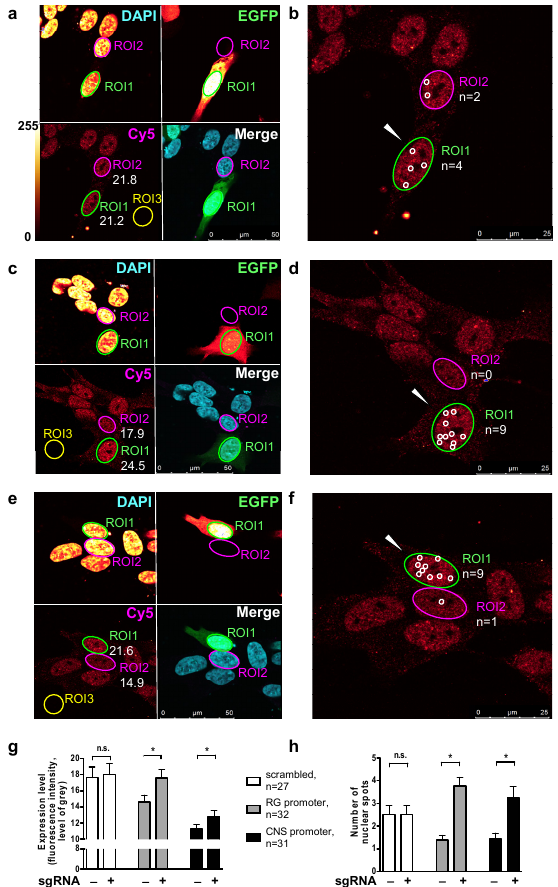
Figure 2. Targeted activation of the RG or CNS promoters increases the expression of PGC-1 α proteins in sgRNA transfected clonal SH-SY5Y cells expressing dCas9-VPR. ( a , c , e ) From top left to bottom right: fluorescent signal of cellular nuclei counterstained with 4 ′ ,6-diamidino-2-phenylindole (DAPI), EGFP, Cy5 (antibody directed against the N-terminal region of reference/CNS PGC-1 α ) and the corresponding merged image in cells transfected with scrambled sgRNA or sgRNAs targeting the RG and CNS PPARGC1A promoters, respectively. Numbers in the lower left section of panels refer to the fluorescence intensity of Cy5 (levels of gray) determined in regions of interest (ROIs) corresponding to the nucleus of adjacent transfected (EGFP-expressing, ROI1) and mock-transfected (not expressing EGFP, ROI2) cells. ROIs depicted outside the cells (ROI3) served to determine the background fluorescence. The fluorescence intensity scale shown in ( a ) also applies to ( c , e ). ( b , d , f ) Magnification of the lower left section of panels (a), (c), and (e); the nuclear spots with a fluorescence intensity > 30 levels of gray in adjacent transfected (white arrowhead) and mock-transfected cells are circled. ( g ) Mean fluorescence intensity and ( h ) number of nuclear spots per nucleus in cells transfected with scrambled sgRNAs, RG- and CNS specific sgRNAs and mock-transfected cells. Means (SE),* p < 0.001, two-tailed, paired Student’s t test; n corresponds to the number of adjacent transfected and mock-transfected cell pairs; n.s., not significant.